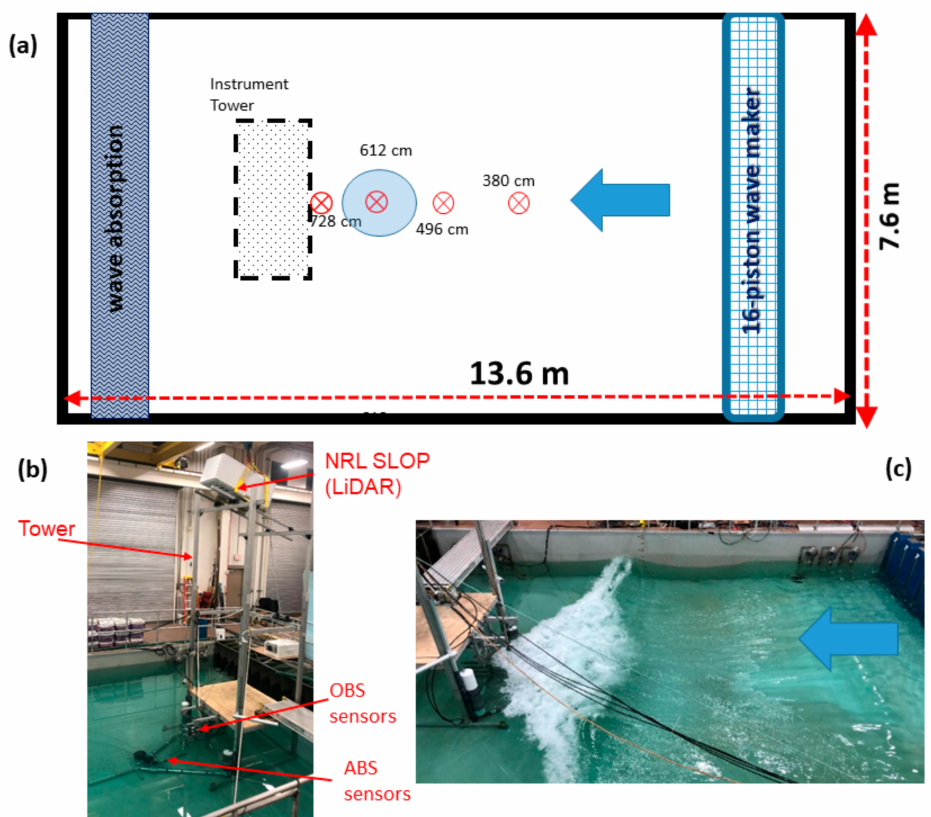
Figure 1. ( a ) Sketch of LASR wave tank and experiment setup; ( b ) Instrument tower and installed measurement sensors; ( c ) A snap shot of wave breaking. The red circled crosses in ( a ) mark the wave gauge locations (x = 380 cm, 496 cm, 612 cm, and 728 cm). The blue shaded circle in ( a ) is the footprint location of LiDAR. The arrows in ( a , c ) are the wave propagation